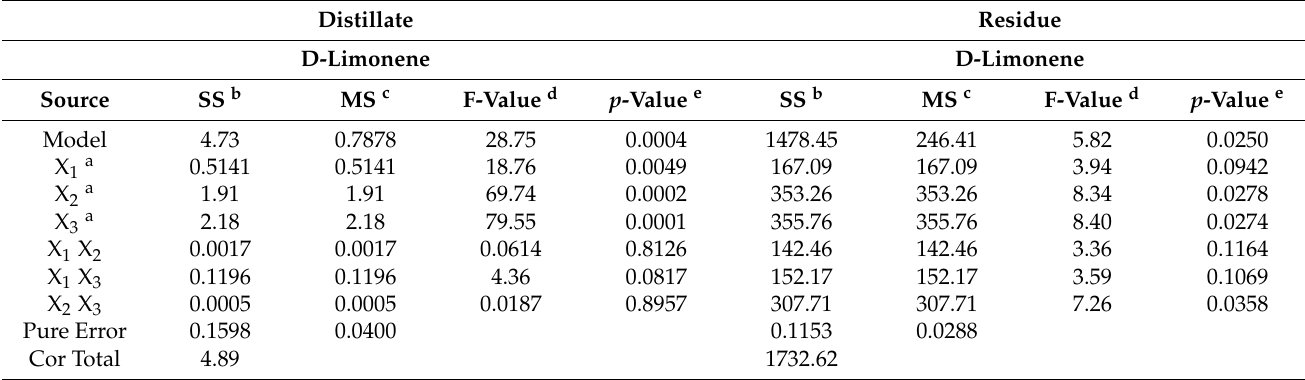
Table 4. ANOVA results for the experimental design of molecular distillation. Distillate